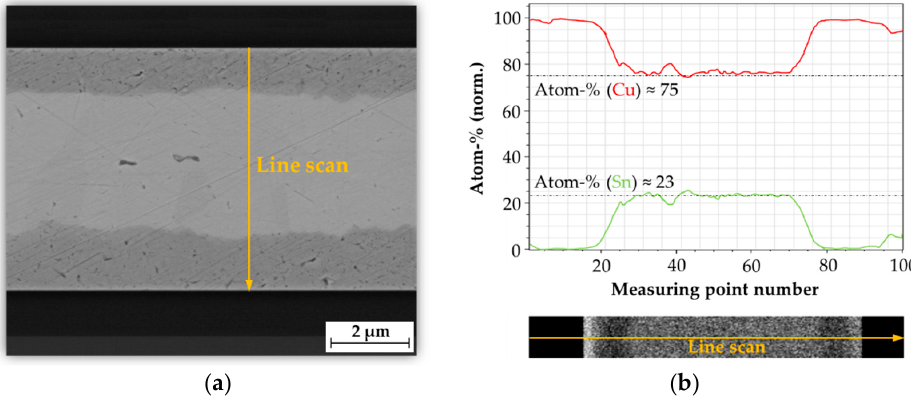
Figure 23. EDX analysis of the formed ε -phase Cu 3 Sn: ( a ) Position of the line scan; ( b ) Atomic percentage as a function of the phase length for Cu and Sn along the line scan.